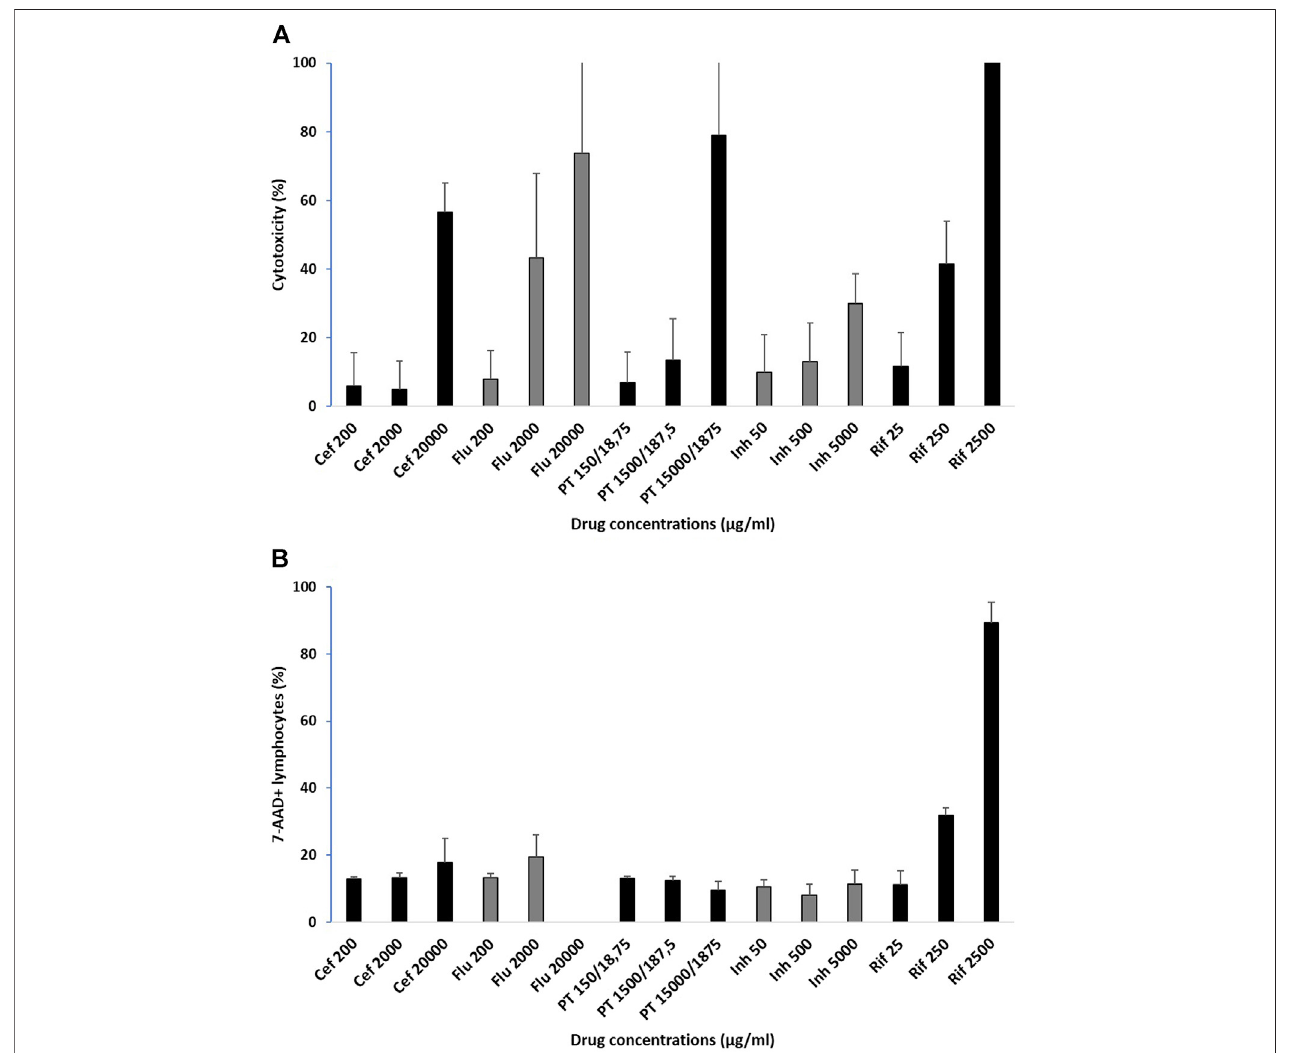
FIGURE 2 | Percentage of cytotoxicity in healthy controls assessed by (A) LDH assay and (B) fl ow cytometry with 7-AAD viability staining in lymphocytes. Cytotoxicity average for 3 normal controls for the drugs included in the study at 3 pre-determined drug concentrations: Cmax , concentrations 10-fold and 100-fold, mean ± sd, Cef: ceftriaxone; Flu: fl ucloxacillin; PT: piperacillin-tazobactam; Inh: isoniazid; Rif: